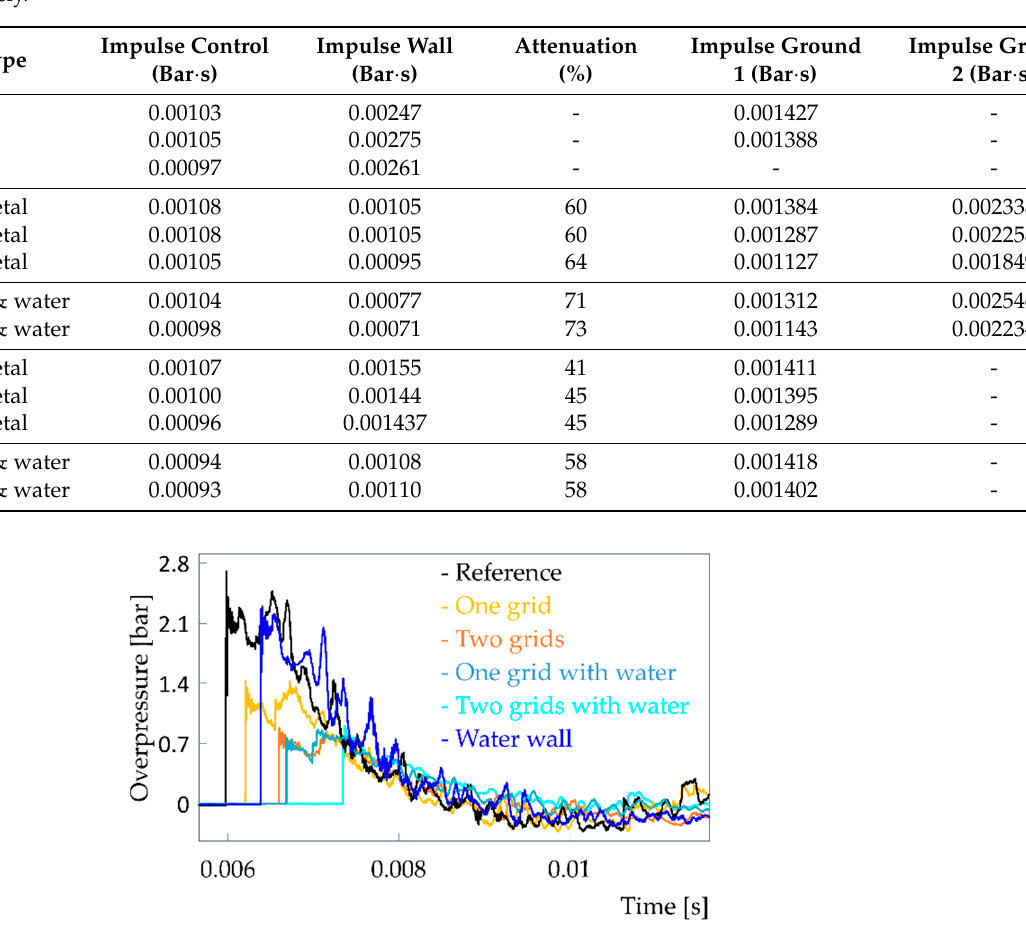
Table 3. Maximum impulse collected by the three sensors (control, inserted into the wall and laid on the ground) for all experiments. The attenuation of impulse measured on the wall relative to the mean value obtained by the reference tests (no plate) is also given. Impulse ground 1 and impulse ground 2 correspond to the maximum value of the first and the second peak, respectively.